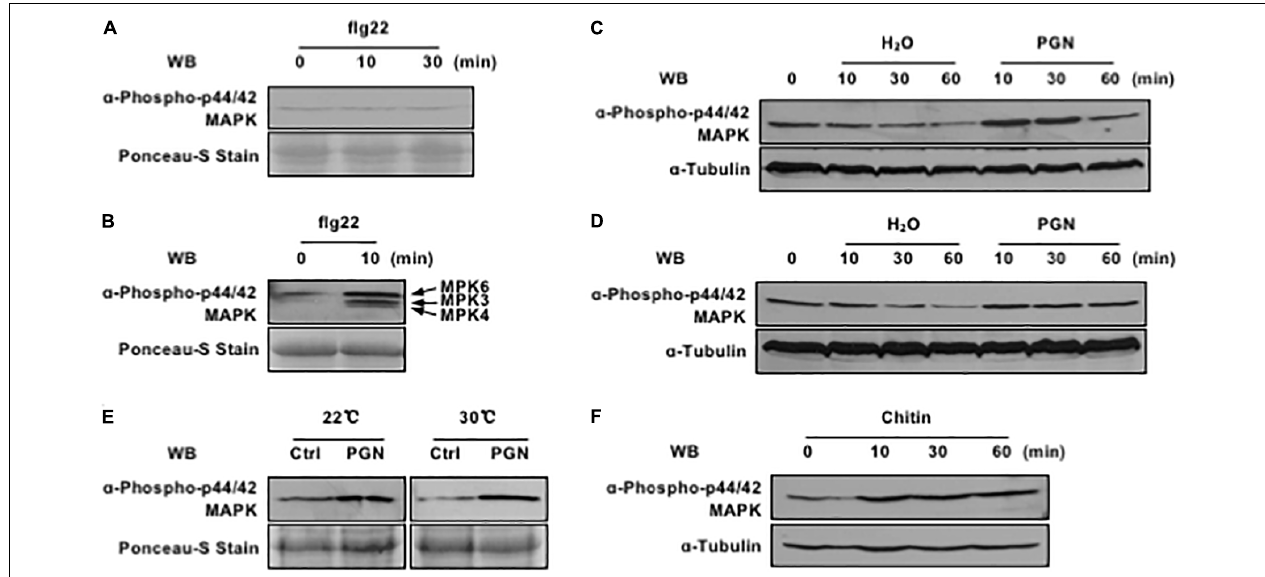
FIGURE 1 | Pathogen-associated molecular pattern (PAMPs) activate MAPK cascade in rice protoplasts. (A) Rice protoplasts do not respond to flg22 treatment. Rice protoplasts were treated with 1 µ M flg22, MAPK activation (top) and loading control (bottom) are shown. (B) flg22 activates endogenous MAPK cascade in Arabidopsis protoplasts. Arabidopsis protoplasts were treated with 1 µ M flg22, MAPK activation (top) and loading control (bottom) are shown. (C) Endogenous MAPK activation is induced by PGN under the lights. Rice protoplasts were treated with or without 5 mg/ml PGN, MAPK activation (top) and loading control (bottom) are shown. (D) PGN has weak effect on endogenous MAPK activation in the dark. Rice protoplasts were treated with or without 5 mg/ml PGN, MAPK activation (top) and loading control (bottom) are shown. (E) Endogenous MAPK cascade is activated at different temperature under the lights. Rice protoplasts were treated with or without 5 mg/ml PGN under the lights for 10 min, MAPK activation (top) and loading control (bottom) are shown. (F) Chitin activates endogenous MAPK cascade in rice protoplasts. Rice protoplasts were treated with 10 µ M chitin, MAPK activation (top) and loading control (bottom) are shown. The data shown here are one representative of three independent